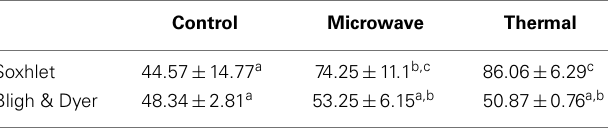
Table 4 | Percentage of total FAME recovery from total extracted lipid